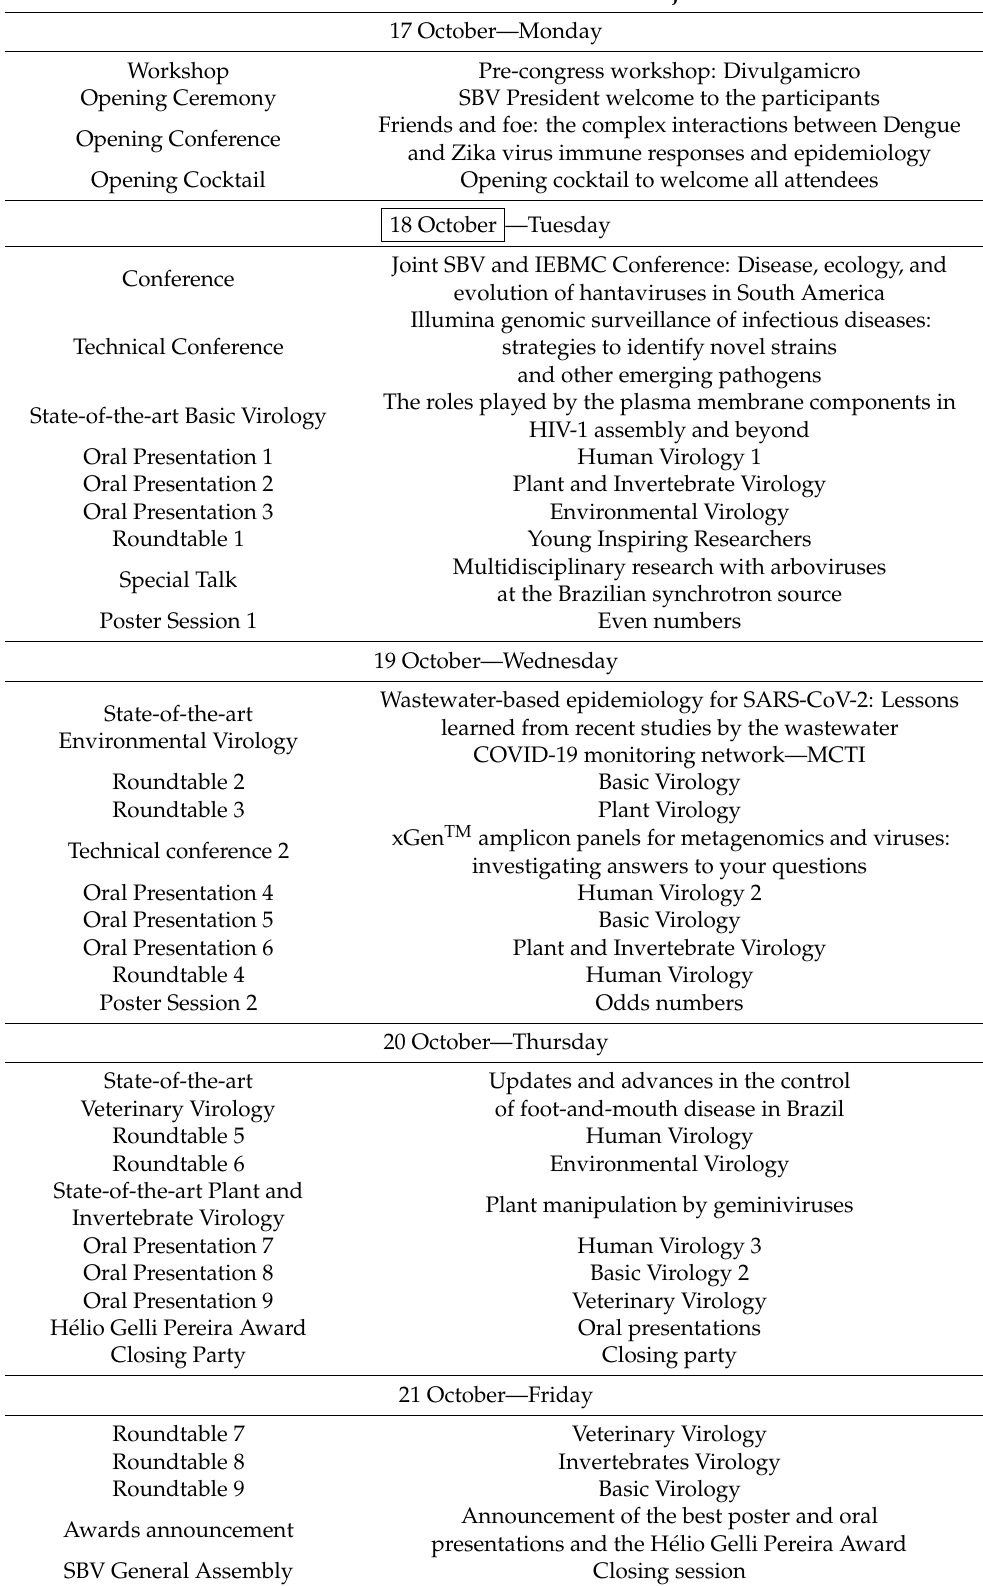
Table 1. Scientific programming schedule of the 33rd Brazilian Society for Virology